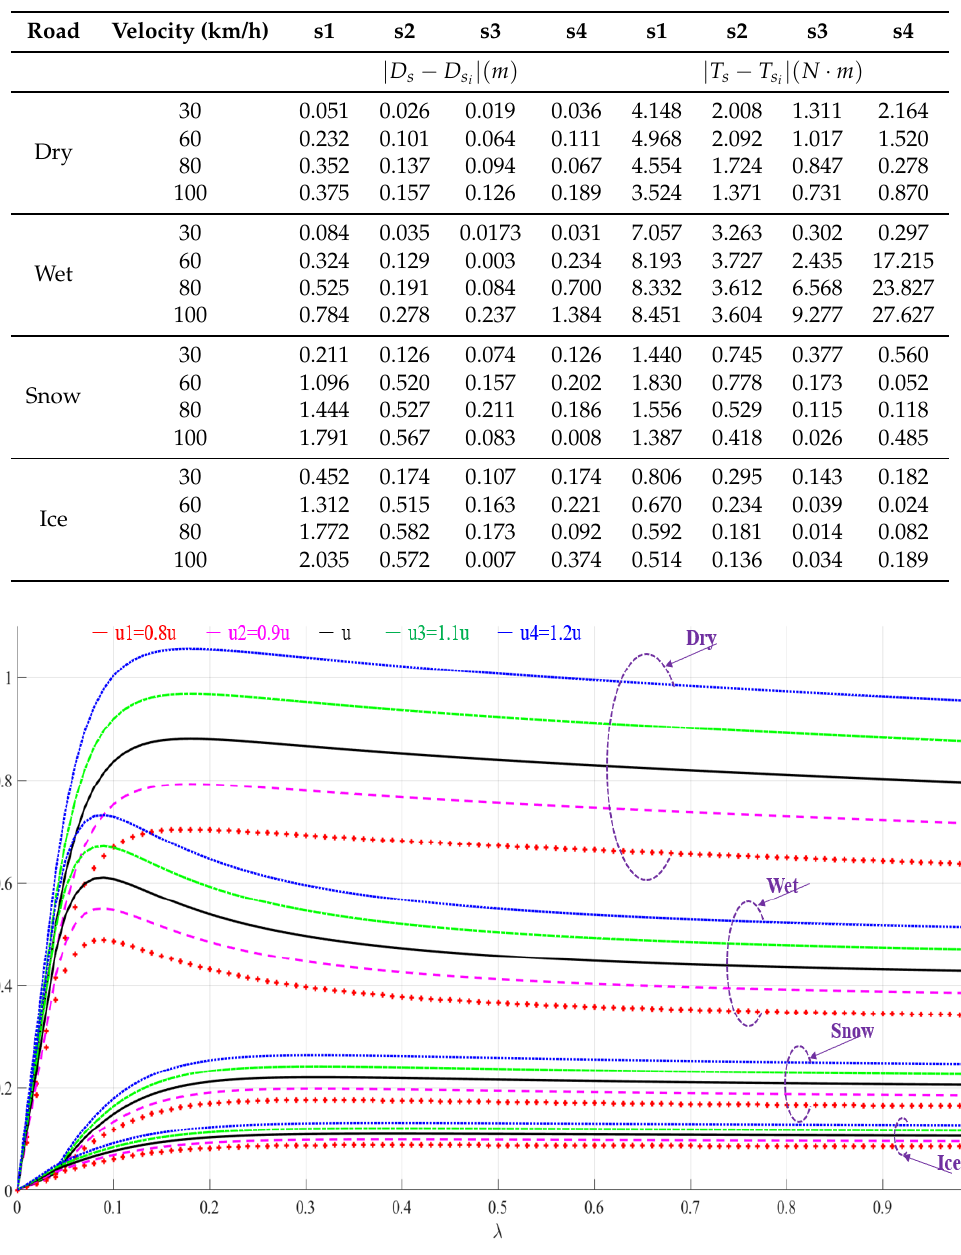
with d s , ( i = 1,2,3,4 ) . i bw